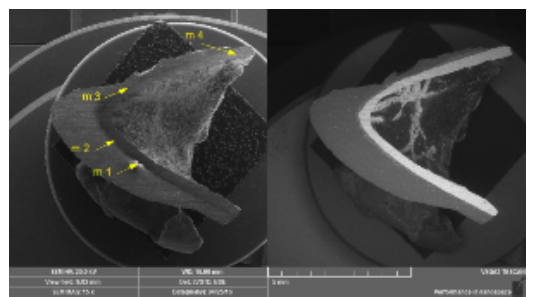
Figure 2. Metal-ceramic crown - detailed image.